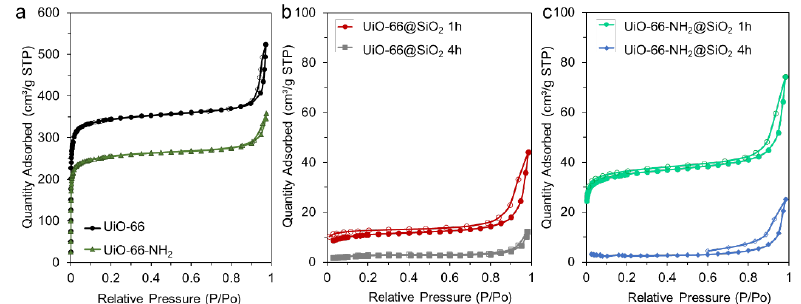
Figure 5. Nitrogen adsorption – desorption isotherms measured for UiO-66 and UiO-66-NH 2 ( a ); UiO-66@SiO 2 1 h and UiO-66@SiO 2 4 h ( b ); UiO-66-NH 2 @SiO 2 1 h and UiO-66-NH 2 @SiO 2 4 h ( c ). Filled markers represent adsorption branches of isotherms, while empty ones designate desorption